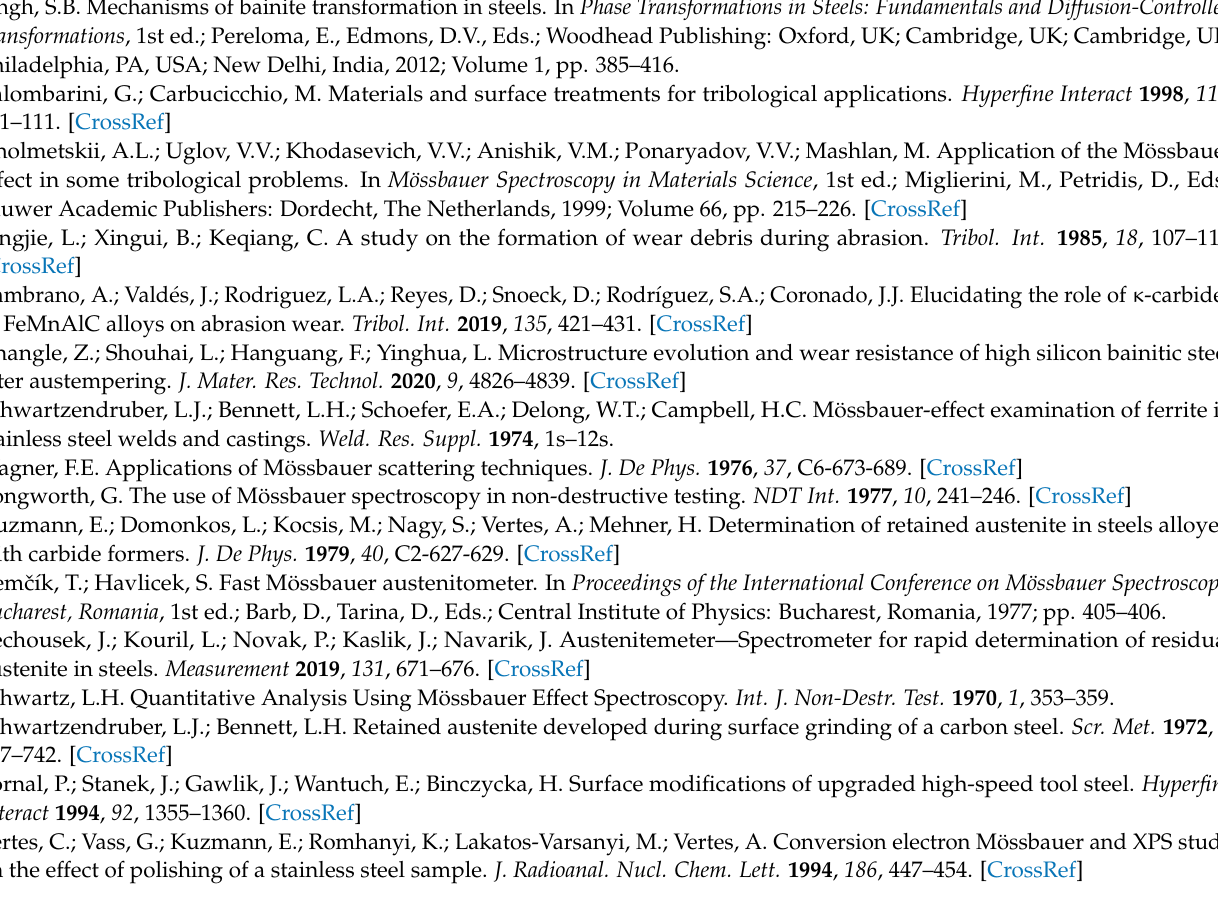
Figure S6: XRD pattern of sample S5, Figure S7: XRD pattern of sample S6, Figure S8: Mössbauer spectra of primary samples (a) S1, (b) S2, (c) S3, (d) S4, (e) S5, and (f) S6, Figure S9: Mössbauer spectra of secondary samples (a) S1-P, (b) S2-P, (c) S3-P-EP, (d) S4-P-EP, (e) S5-P, and (f) S6-P, Figure S10: SEM/BSE (backscattered electrons) regime microscopy image of sample surface S3-P-EP, Figure S11: EBSD image of sample surface S3-P-EP central part (core), Figure S12: EBSD image of sample surface S4-P-EP central part